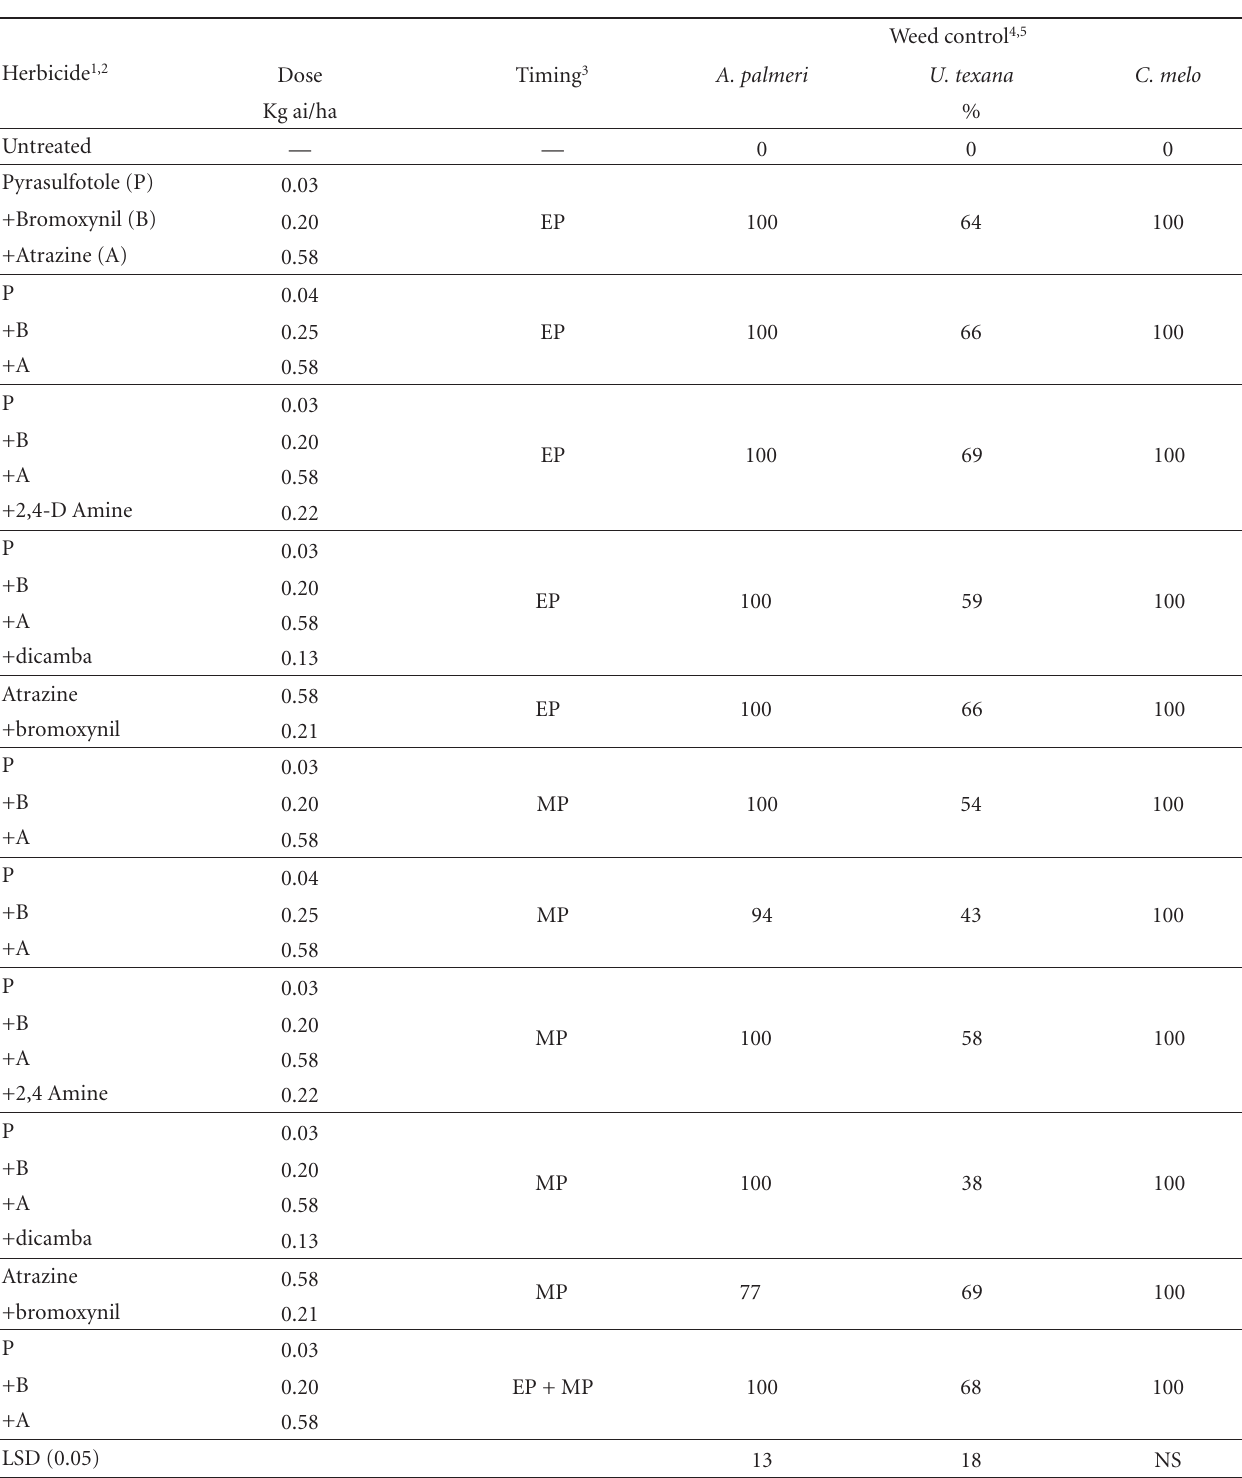
Table 2: Weed control at Lubbock and Yoakum as influenced by pyrasulfotole plus bromoxynil combinations in 2009, 4 weeks after MPOST